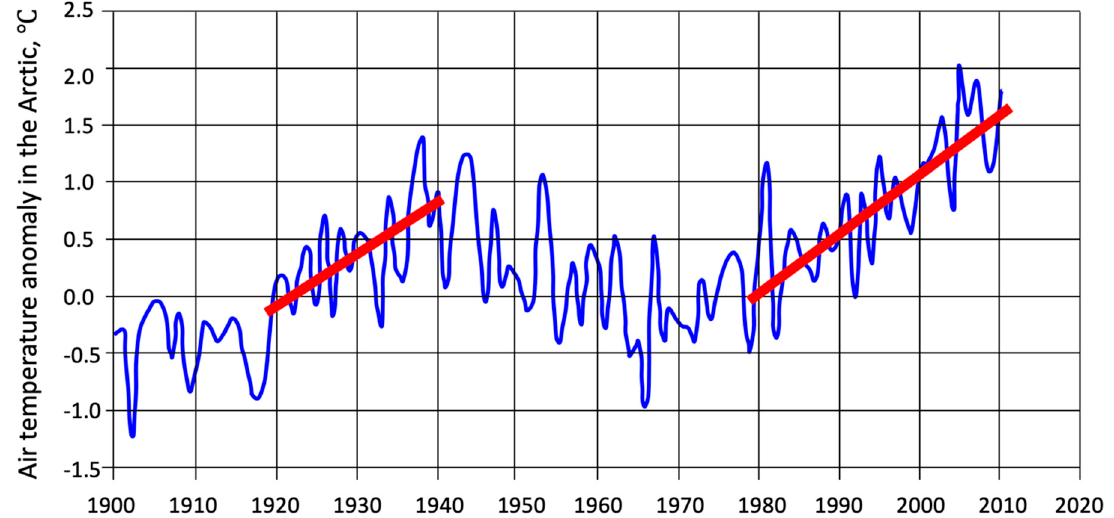
Figure 1. Arctic air temperature anomaly variation since 1900 (data compiled by Arctic and Antarctic Research Institute). Thick red lines indicate the phases of abrupt warming.